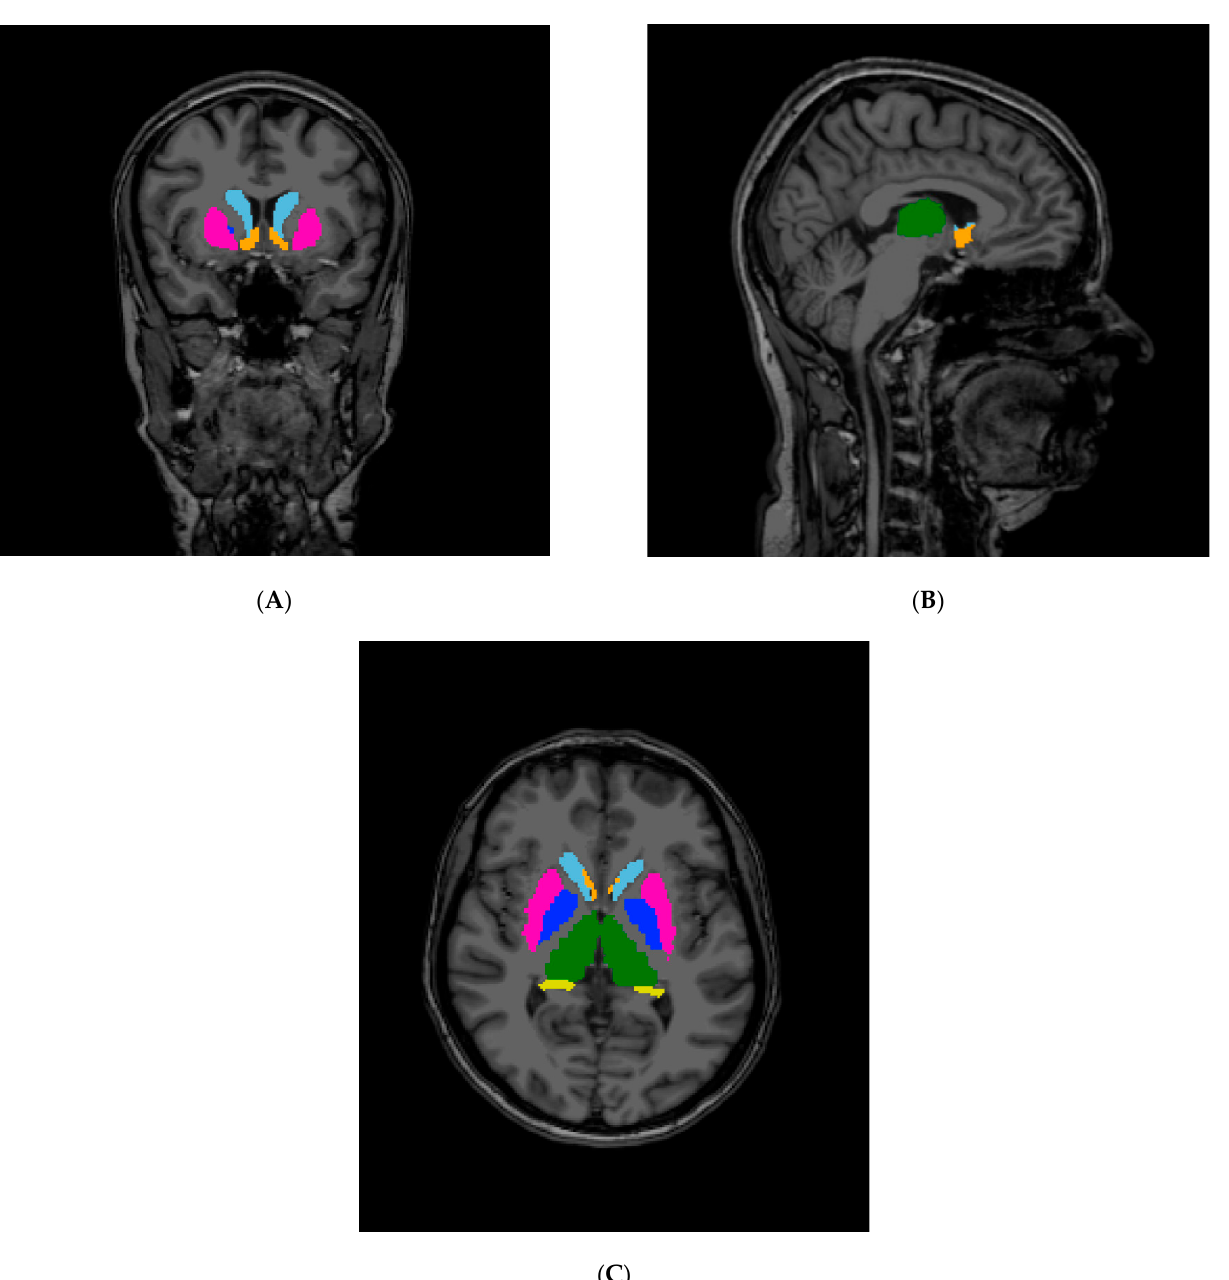
Figure 1. Brain structures reconstruction, FreeSurfer software. ( A ) coronal plane, ( B ) saggital plane, ( C ) axial plane; brain structures: pink—putamen, blue—pallidum, green—thalamus, yellow—hippocampus, orange—accumbens, light blue—caudate, turquoise—amygdala.